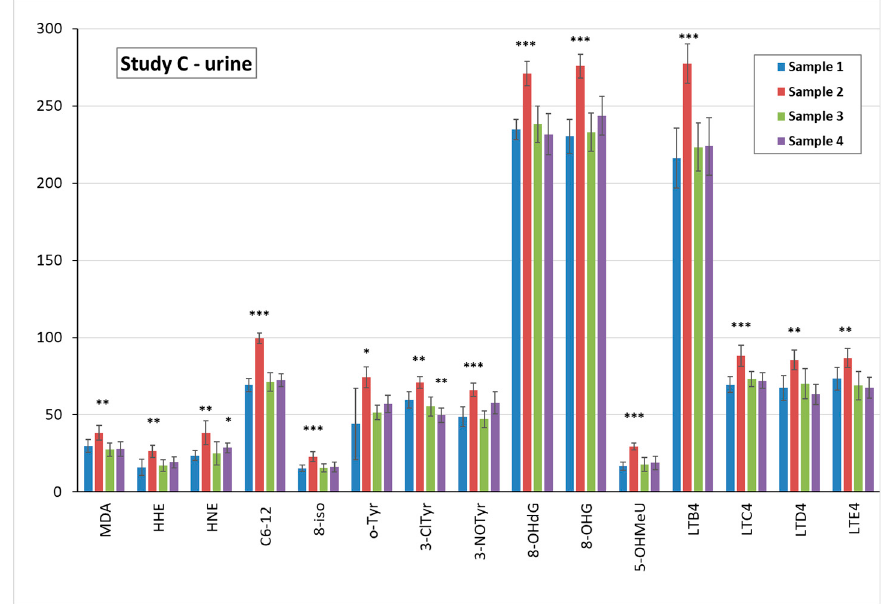
Figure 6. Comparison of the mean levels of oxidative stress and inflammatory markers in study C exhaled breath condensate pre-exposure (sample 1) and after both sunscreen and UV exposure (samples 2–4). * ( p < 0.05) ** ( p < 0.01) *** ( p < 0.001). MDA = malondialdehyde, HHE = 4-hydroxy- trans -hexenal, HNE = 4-hydroxy- trans -nonenal, C6-12 = aldehydes C6-C12, (all ng/mL); 8-iso = 8-isoProstaglandin F2 α , 8-OHdG = 8-hydroxy-2-deoxyguanosine, 8-OHG = 8-hydroxyguanosine, 5-OHMeU = 5-hydroxymethyl uracil, o-Tyr = o-tyrosine, 3-ClTyr = 3-chlorotyrosine, 3-NOTyr = 3-nitrotyrosine, leukotrienes (LT) LTB4, LTC4, LTD4, LTE4 (all pg/mL).